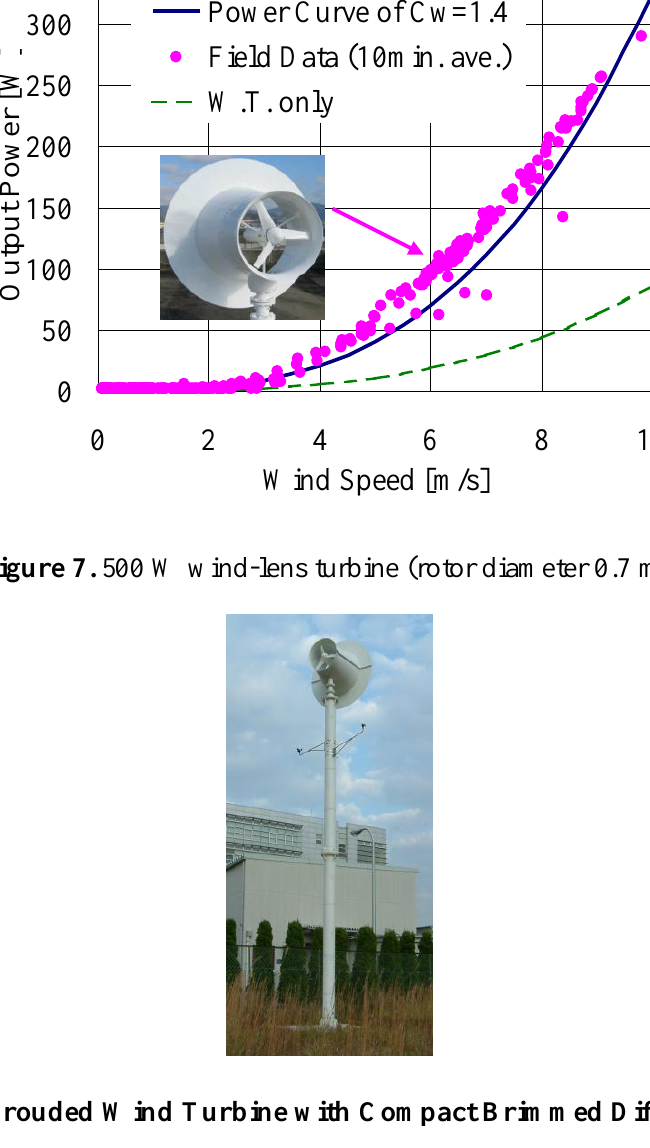
Figure 6. Field experiment of 500 W wind turbine with wind-lens. C